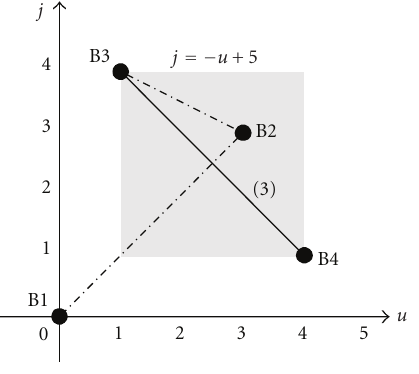
Figure 7: Interval intersection for k = 1.